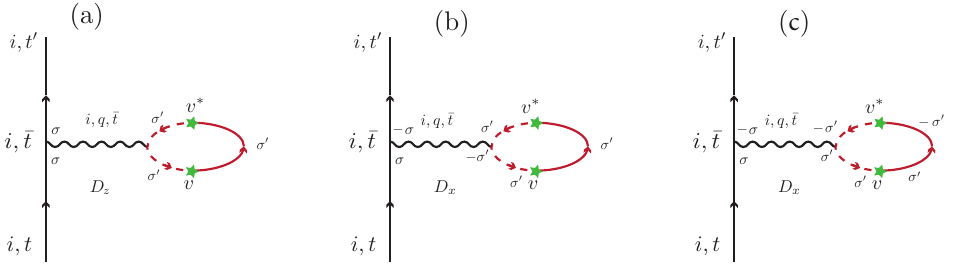
Figure 3. Hall-Klemm diagrams for the Knight shift linewidth changes at T = 0. The vertical solid lines on the left are the nuclear G n ( 1,1 (cid:48) ) , the wiggly horizontal line represents the hyperfine interaction, the dashed curves represent G e , the stars represent the excitation from the local orbitals to the conduction band, and the solid counterclockwise arrowed curves represent the conduction electron G cond . ( a ) represents the leading Knight shift contribution arising from D z ; ( b , c ) represent the two leading contributions to the linewidth changes arising from D x [43]. Reprinted with permission of